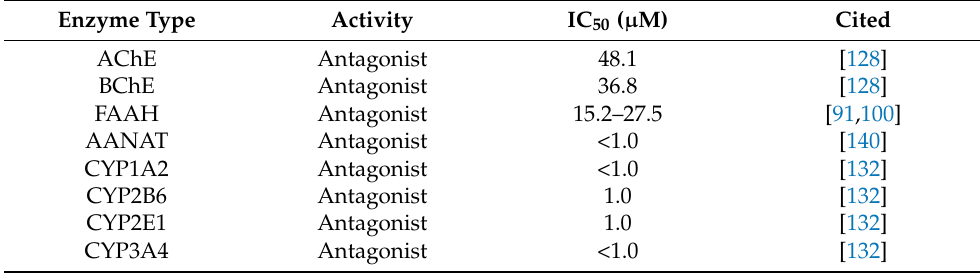
Table 4. Neuro and hepatic enzymes inhibited for